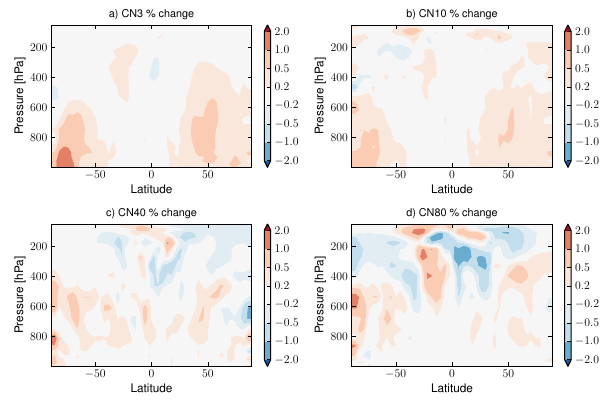
Fig. 6. Percentage change between the solar-minimum and solar- maximum BASE simulations of zonal-mean CN3, CN10, CN40 and CN80 concentrations. Higher values (red) indicate more particles in the solar-minimum (0.4GV modulating potential)